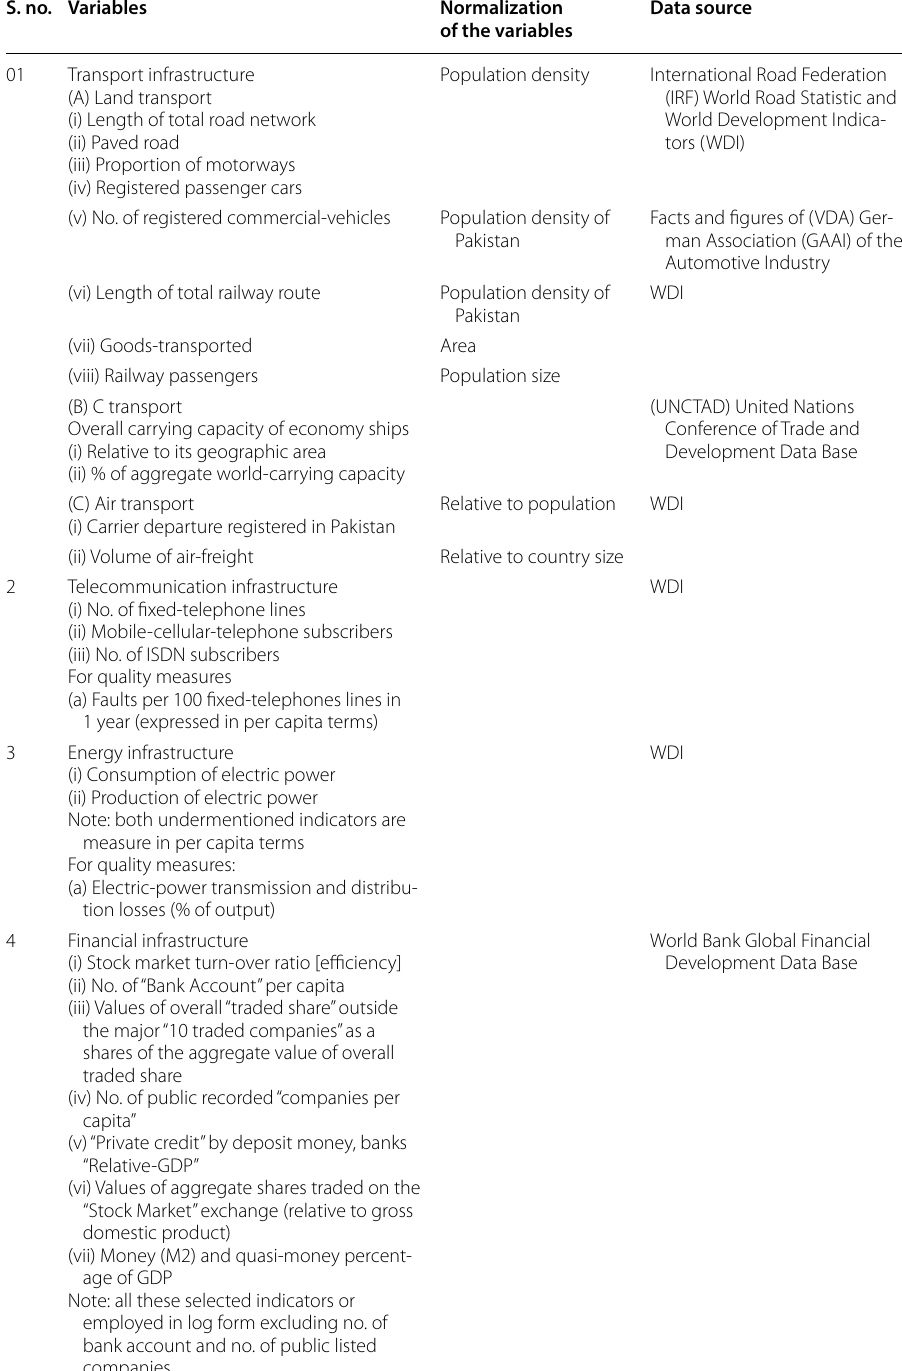
Table 9 Variables and data sources of Global Infrastructure Index S. no.